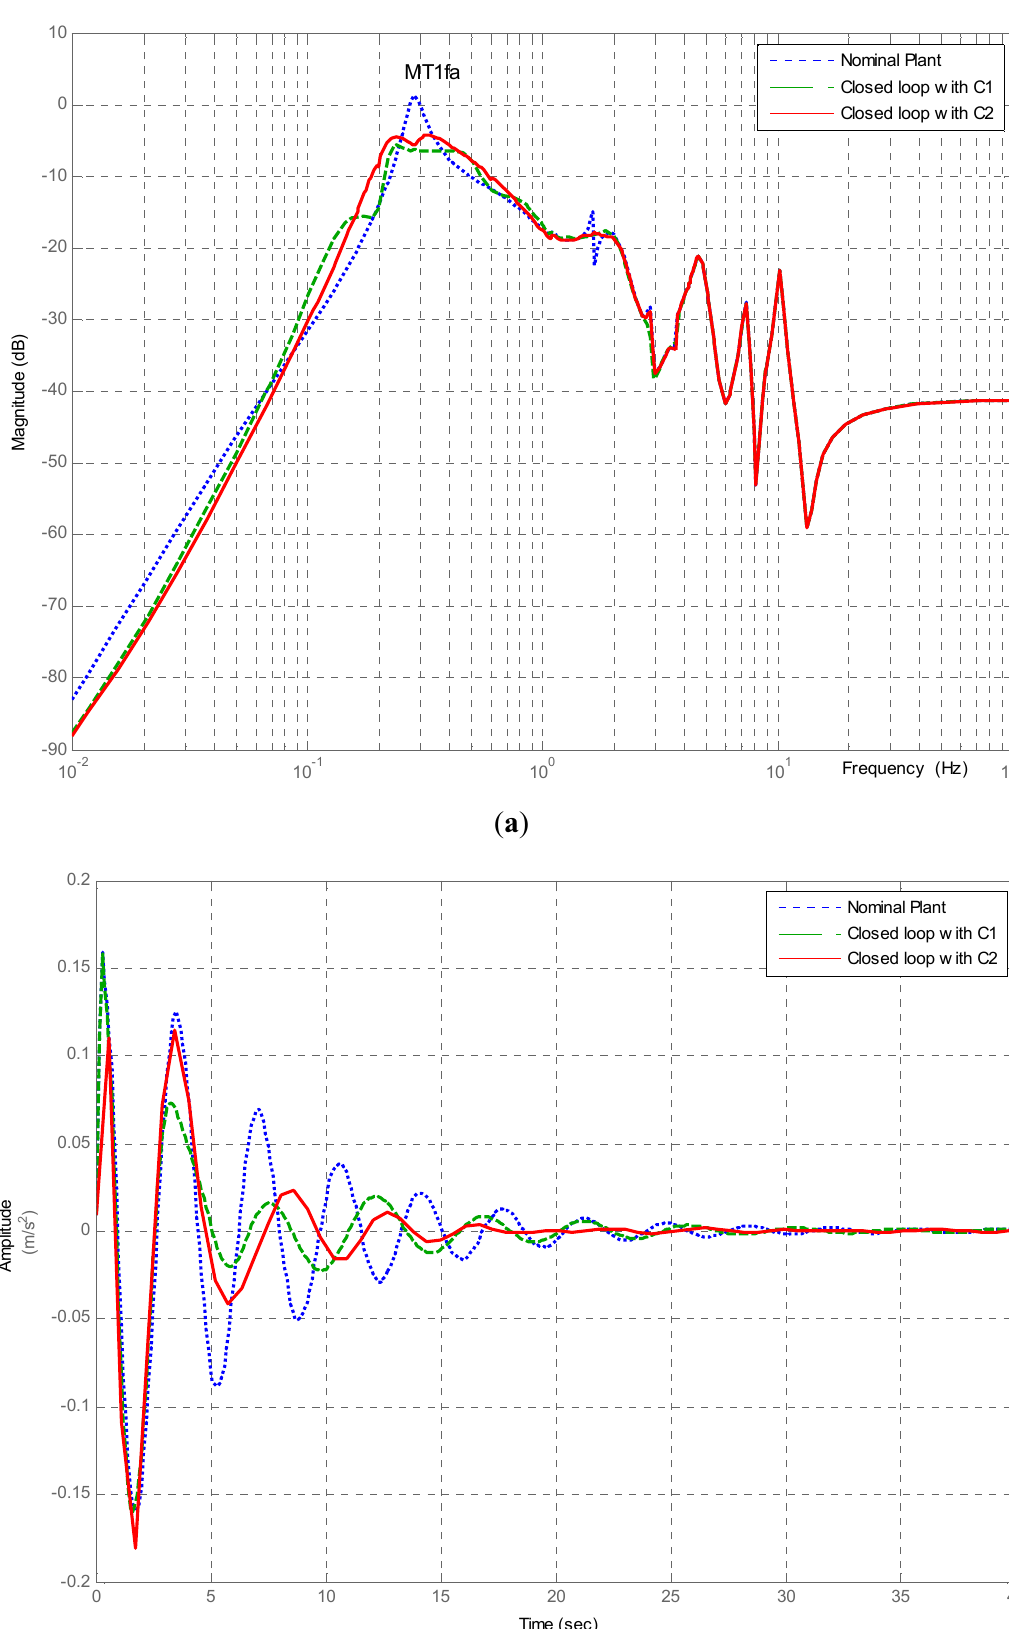
Figure 15. Tower top fore-aft acceleration response for a wind input ( a ) Frequency response; ( b ) Time domain wind step